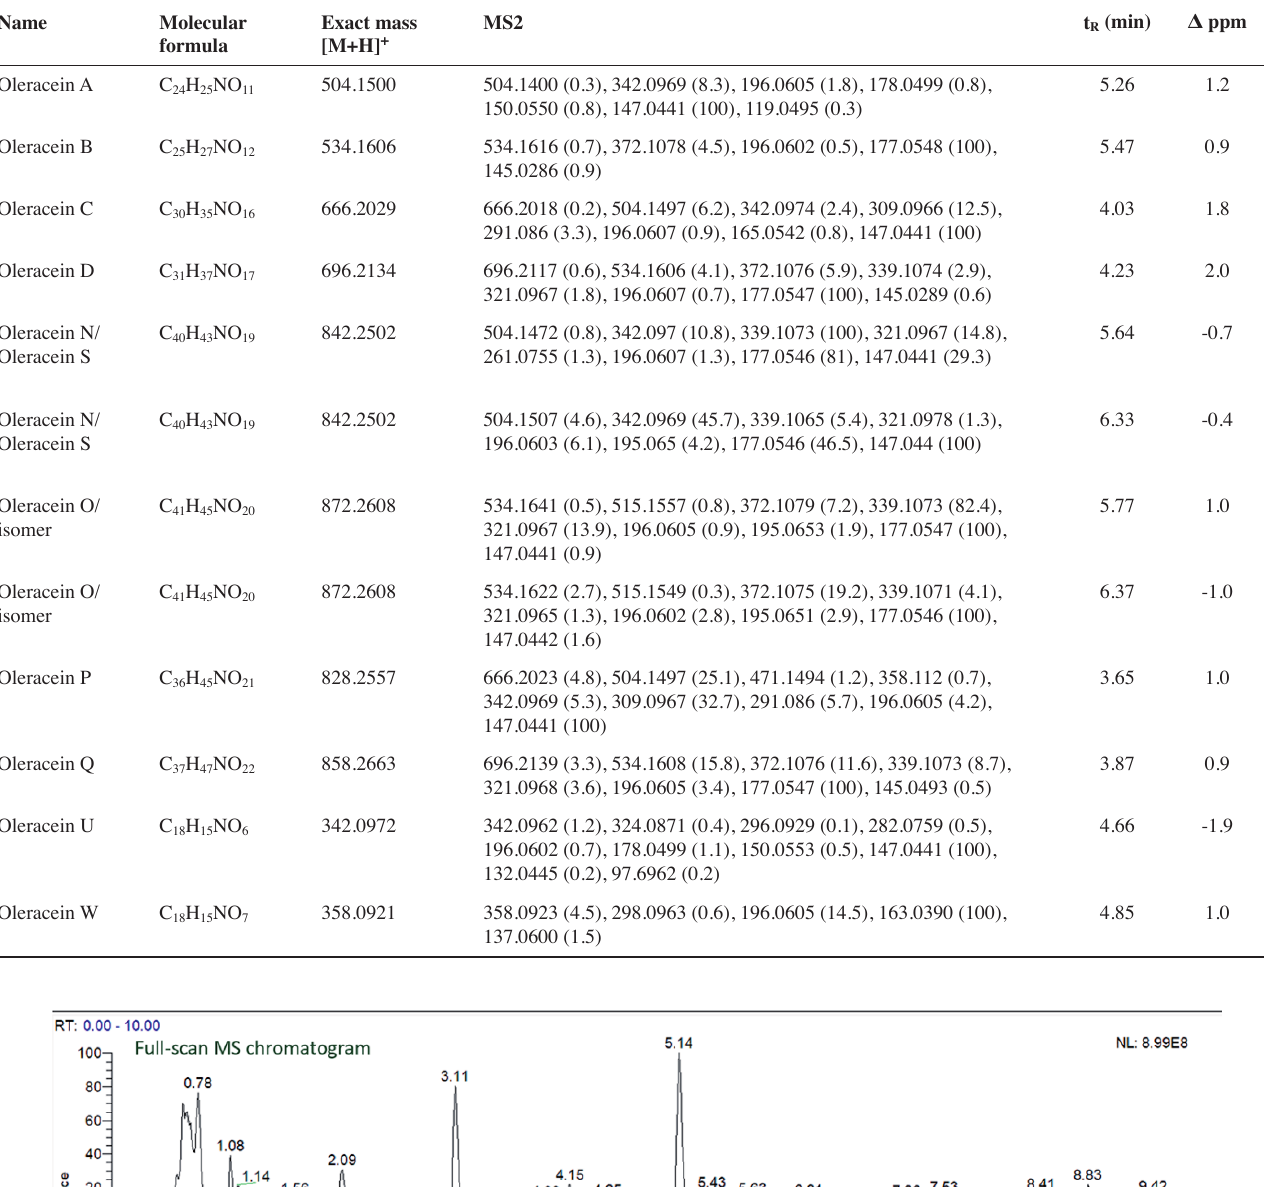
Tab. 8: Mass spectrometric and chromatographic data for identified Oleraceins by UHPLC-MS.